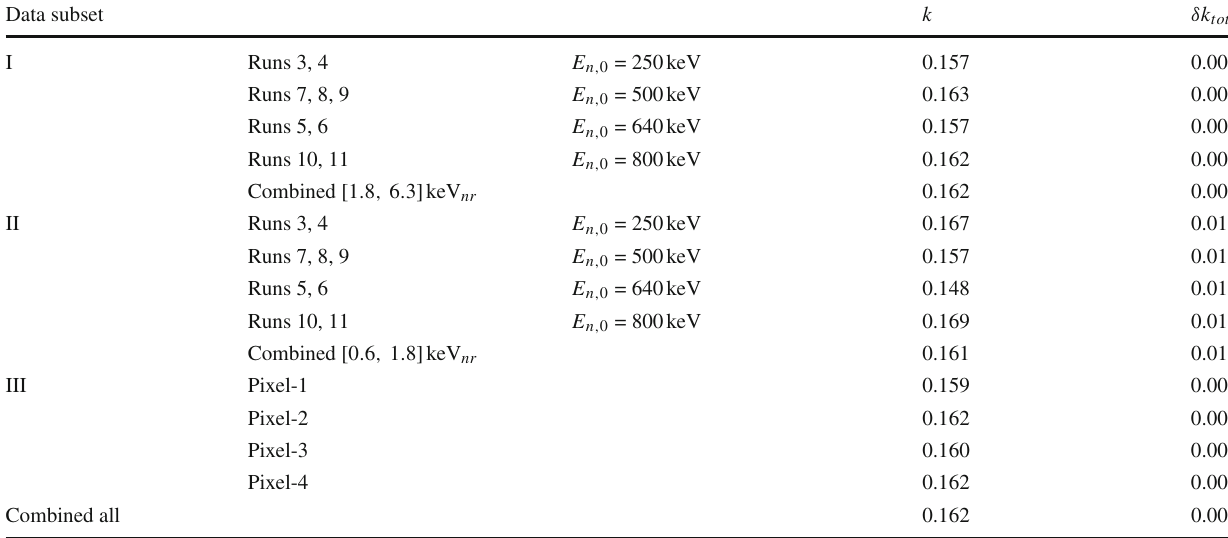
Fig. 14 Ionization quenching factor as a function of the nuclear recoil uncertainties (statistics and spatial coordinates measurements for each angle), whereas the correlated uncertainties (beam energy, energy scale energy. The data points are obtained for the four different data sets, and trigger efficiency) are represented by the blue band. The best-fit of each one corresponding to a different nominal neutron beam energy. these data points within a Lindhard theory description is obtained for Due to the low statistics for the beam energy at 250keV only upper k = 0 . 162 ± 0 . 004 (stat + sys) and is illustrated by the black curve limits were extracted for the lowest energy data points. They are rep- resented by the orange arrows. Indicated error bars are uncorrelated Table 3 Best-fit of quenching data separated into different data sets (divided into beam energies and pixels) Data subset k δ k